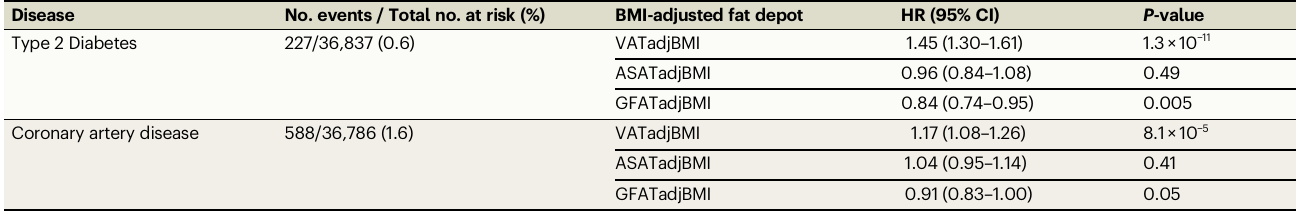
Table 2 | Association of BMI-adjusted fat depot volumes with incident disease